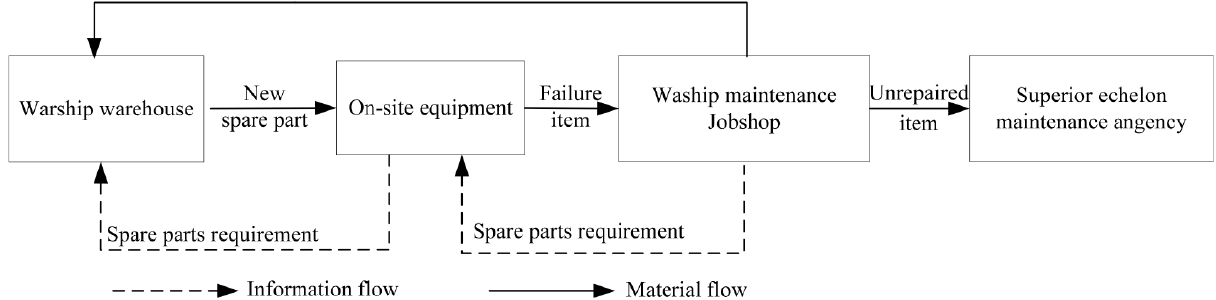
Figure 2. Feedback relationship of warship spare parts support process